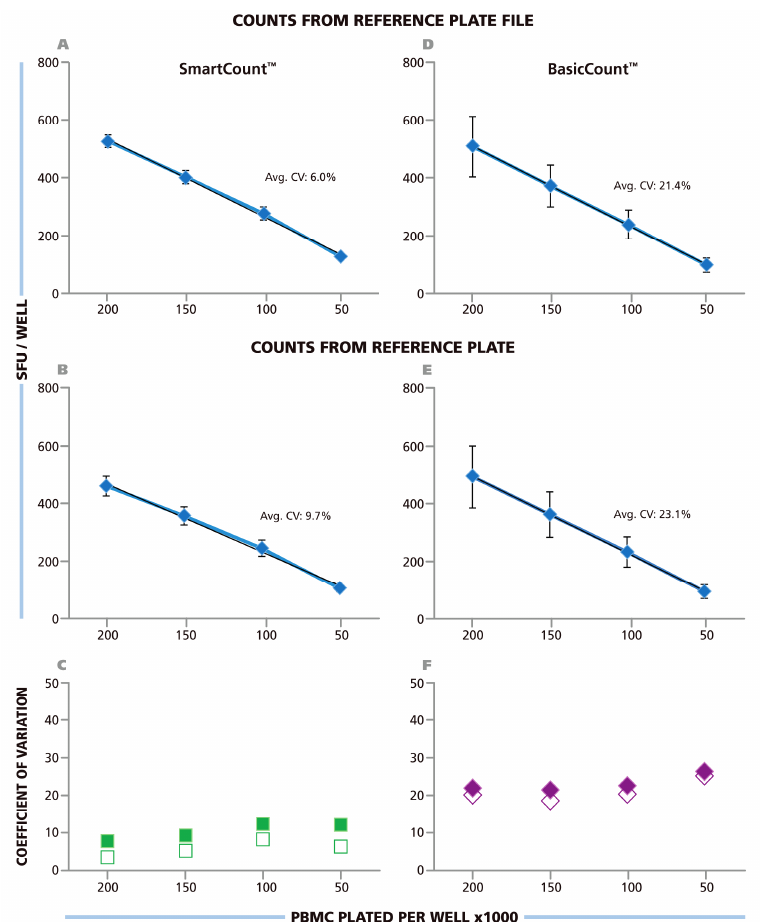
Figure 6. Spot counts from ten labs using SmartCount™ or Basic Count™ respectively. The Reference Plate File ( A & D ) or the Reference Plate scanned with the 10 different instruments of the nine participating laboratories ( B & E ) were counted either in SmartCount™ mode ( A & B ), or in Basic Count™ mode ( D & E ). In SmartCount™ mode, the investigators were permitted to pick any well(s) of the Reference Plate as the representative well(s) as long as a total of 500 cumulative spots, from replicate wells were made available for the software to apply statistical analysis. In Basic Count™ mode, the investigators fine-tuned counting parameters manually to accomplish the count according to their best judgment. ( A – D ) The mean (from 10 laboratories) of mean (from 24 replicates) and corresponding SD is shown in these panels with the average CV for the entire plate specified. ( C and F ) The CV for the four cell densities are shown with the counts for the Reference Plate File in open symbols, and from the Reference Plate in closed symbols, as